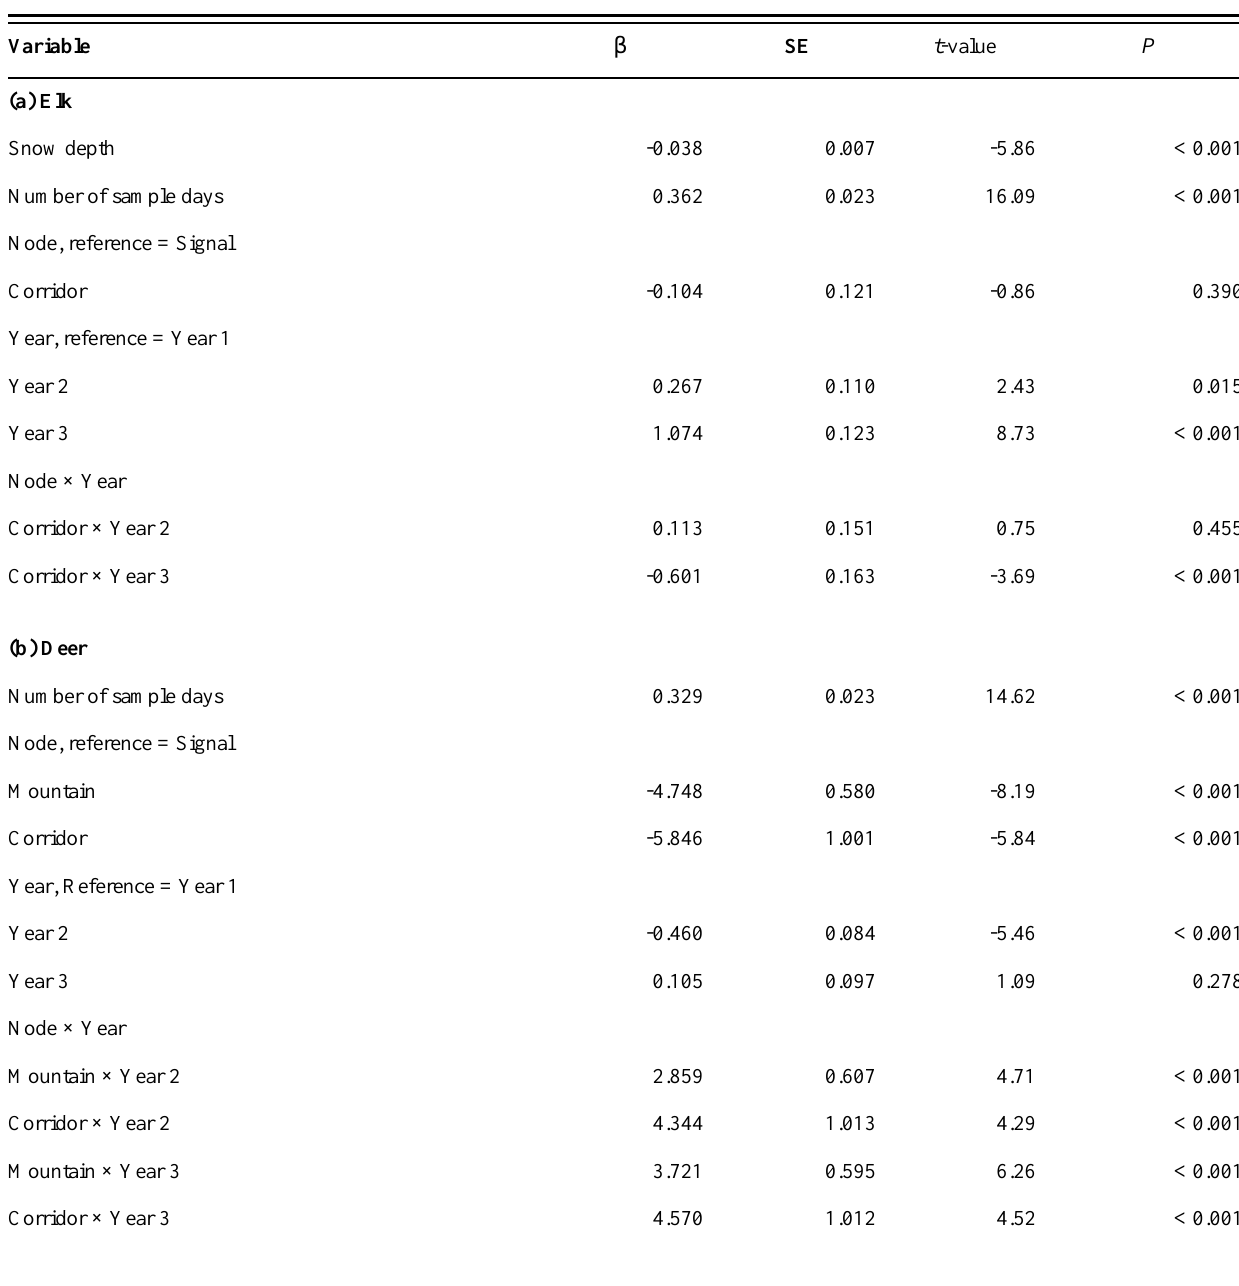
Table 3. Generalized linear models with a Poisson distribution predicting the number of (a) elk and (b) deer on a snow